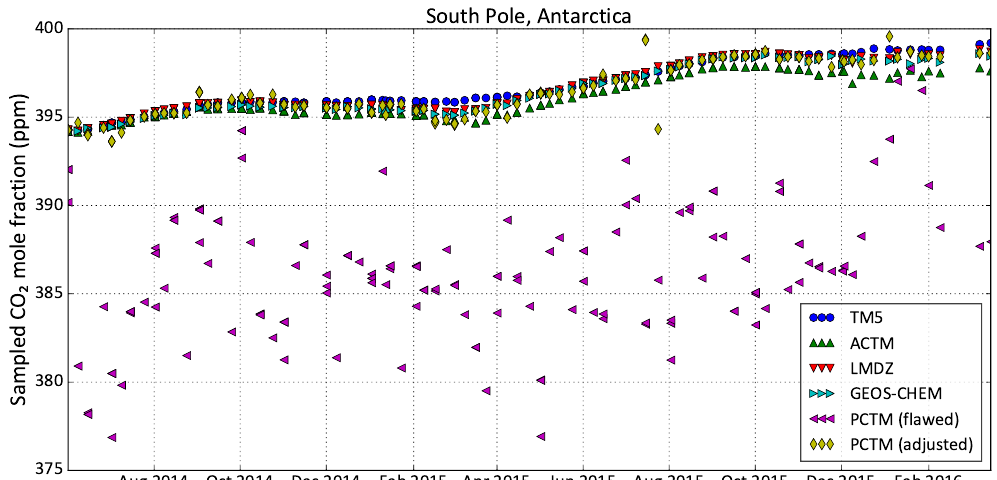
Figure A1. The modeled time series of the CO 2 mole fraction at NOAA flask sampling times at the South Pole station from all the models. PCTM (“PCTM (flawed)” here) is seen to have a problem, giving unrealistically low CO 2 values with unrealistically high variability. Moving the sampling site north by 2 ◦ along the Greenwich meridian, just for PCTM, greatly alleviates the problem (“PCTM